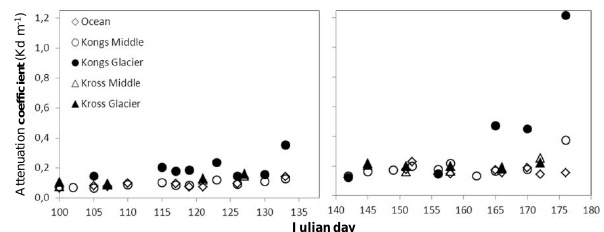
1 Figure 3. Change in light attenuation coefficients over time (Julian days) for the 5 stations.2 Fig. 3. Change in light attenuation coefficients over time (Julian Kongs=Kongsfjorden; Kross= Krossfjorden. Left panel: 2008 campaign; right panel: 20073 days) for the 5 stations. Kongs = Kongsfjorden; Kross = Krossfjor- campaign.4 den. Left panel: 2008 campaign; right panel: 2007 campaign.